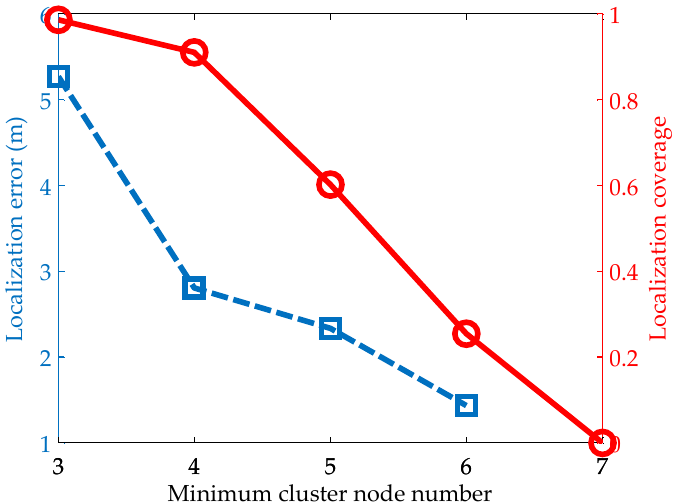
Figure 5. Impacts of the particle number on localization accuracy and time.